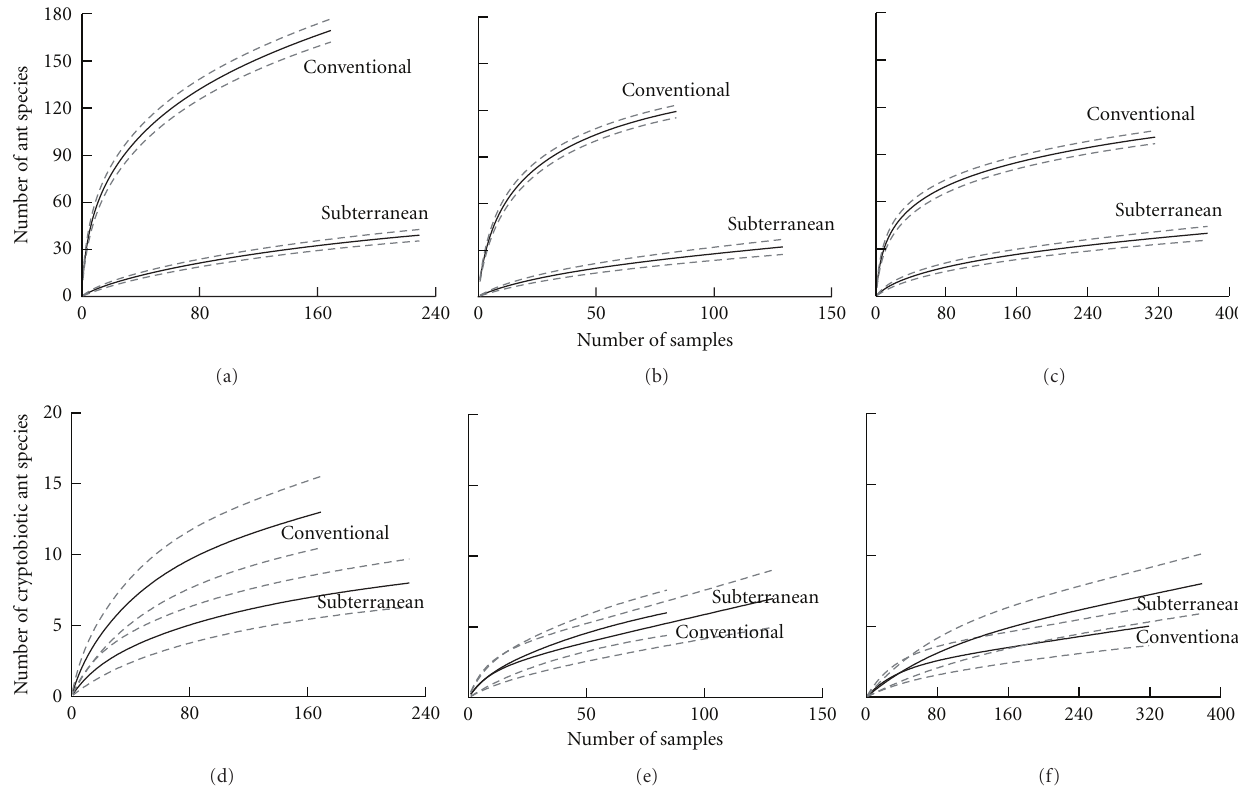
Figure 2: Sample-based species accumulation curves of the total number of ant species and the number of cryptobiotic species collected in subterranean or in conventional (i.e., on soil surface) pitfall traps placed in forests (a, d), savannas (b, e), or crop fields (c, f). Dotted lines represent one standard deviation around mean values.